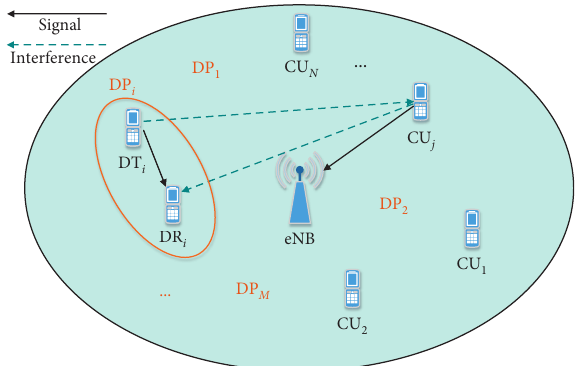
Figure 1: Schematic of the D2D communication